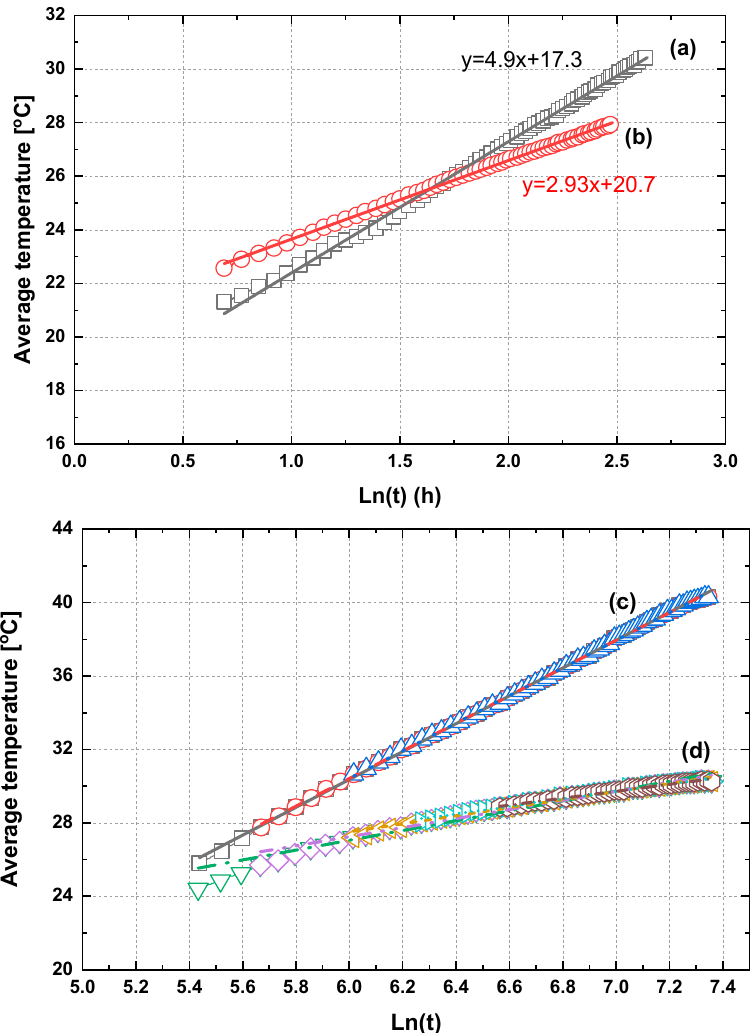
Figure 11. Linearization of the average temperature of the single- and two-well type SCW systems: ( a ) single-well type (no bleeding); ( b ) single-well type (10% bleeding); ( c ) two-well type (no bleeding); ( d ) two-well type (25% bleeding).